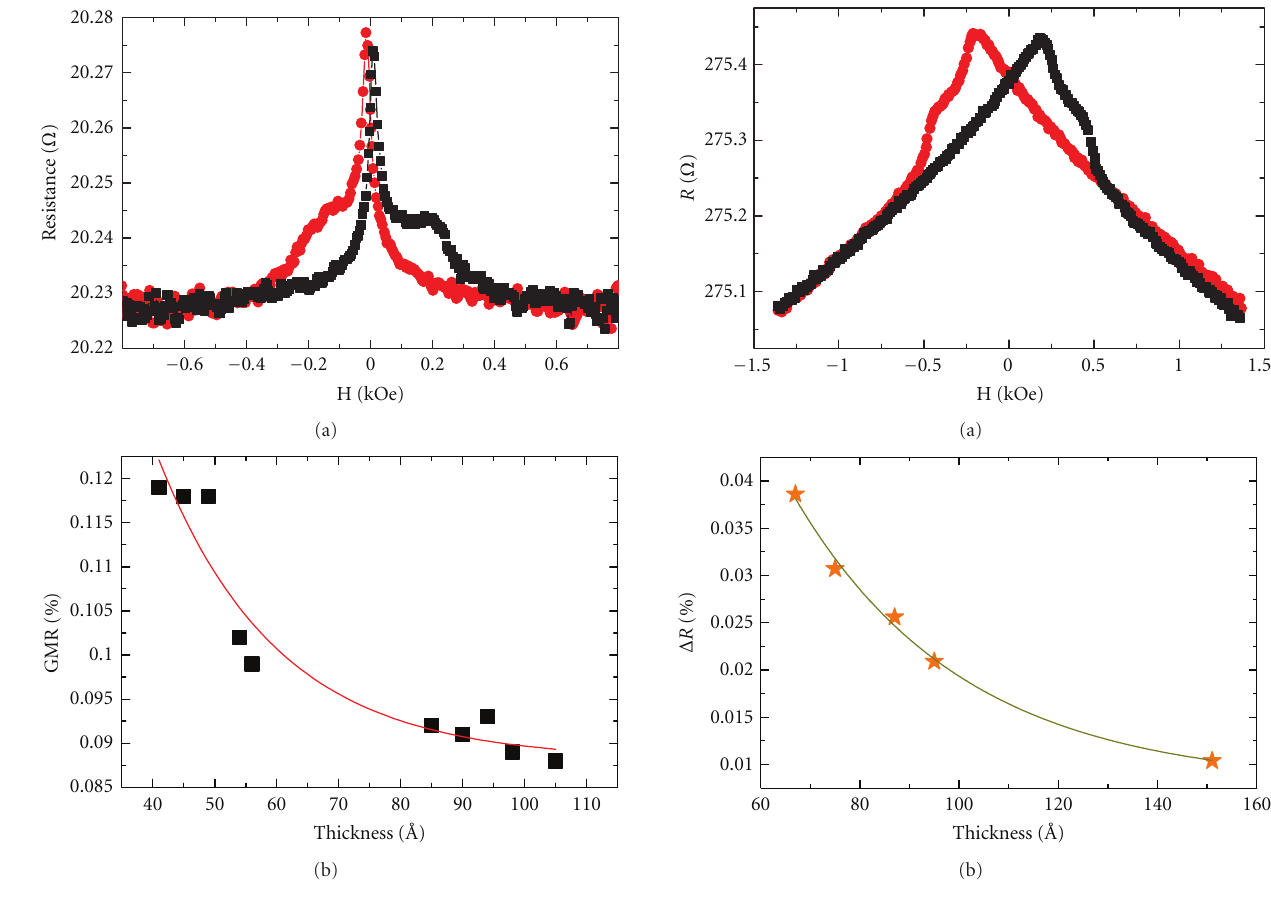
Figure 6: (a) Room temperature current in plane magneto re- sistance measurements on Py(300 ˚A)/Cr(41 ˚A)/Fe 3 O 4 (300 ˚A) spin valves. The shoulders are the antiparallel state. The AMR peak of the Py is unavoidable because of the conductivity mismatch between the metals and the oxide. (b) GMR as a function of Cr spacer layer thickness.